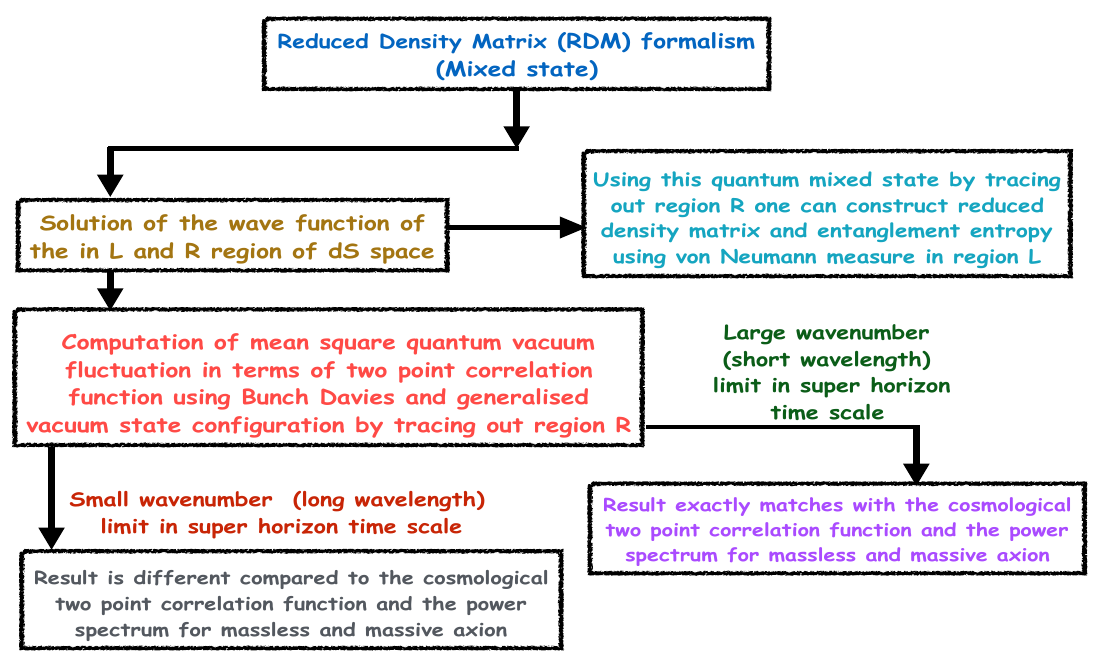
Figure 8. Schematic diagram for the computation algorithm of reduced density matrix formalism for mixed quantum state of axion in de Sitter hyperbolic open